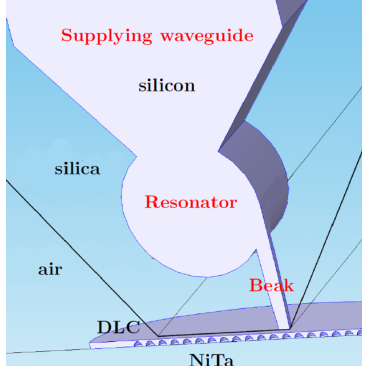
Figure 35. Scheme of a local-field dielectric transducer made of silicon. Diamond-like carbon (DLC) layer with equally spaced FePt grains is placed above NiTa substrate. FePt grains of size 14nm are arranged in the square lattice with the period of 20nm. The other parameters and informations can be obtained in Ref. [189]. Optical properties of FePt alloy and silicon were obtained from [232] and [233], respectively. The permittivity of NiTa alloy is calculated as the arithmetic mean of Ni and Ta permittivities. DLC permittivity is around ε DLC = 3.5 coming from [234,235], reprinted figure with permission from [189]. Copyright (2017) by the American Physical Society.